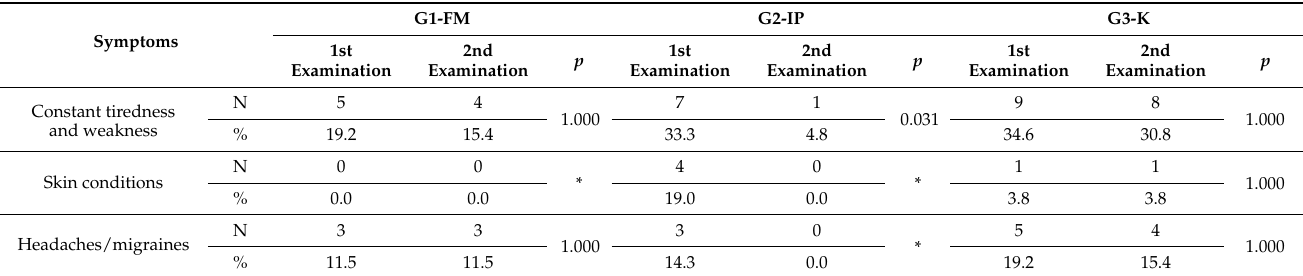
Table 4. Frequency of extra-intestinal symptoms in patients before and after dietary